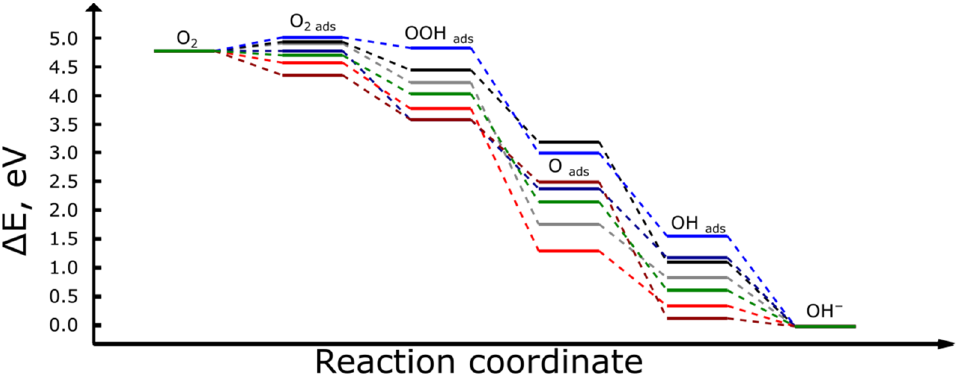
Figure 4. Free energy profile of ORR on the studied catalysts: CoN 4 —grey; CuN 4 —black; NiN 4 —blue; MnN 4 —red; ZnN 4 —dark red; Cr(OH)N 4 —green. The ideal catalyst—dark blue.